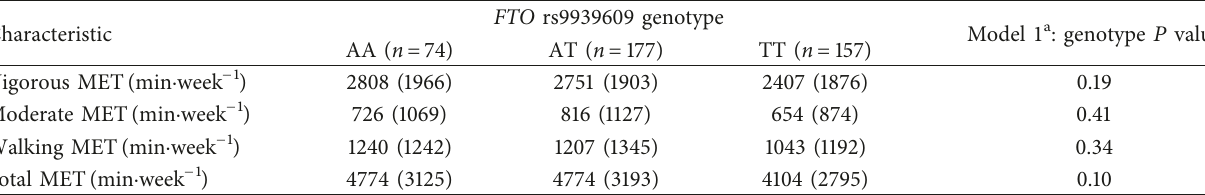
Table 3: Physical activity levels in men and women carrying different risk variants of the FTO rs9939609 single nucleotide polymorphism. Characteristic